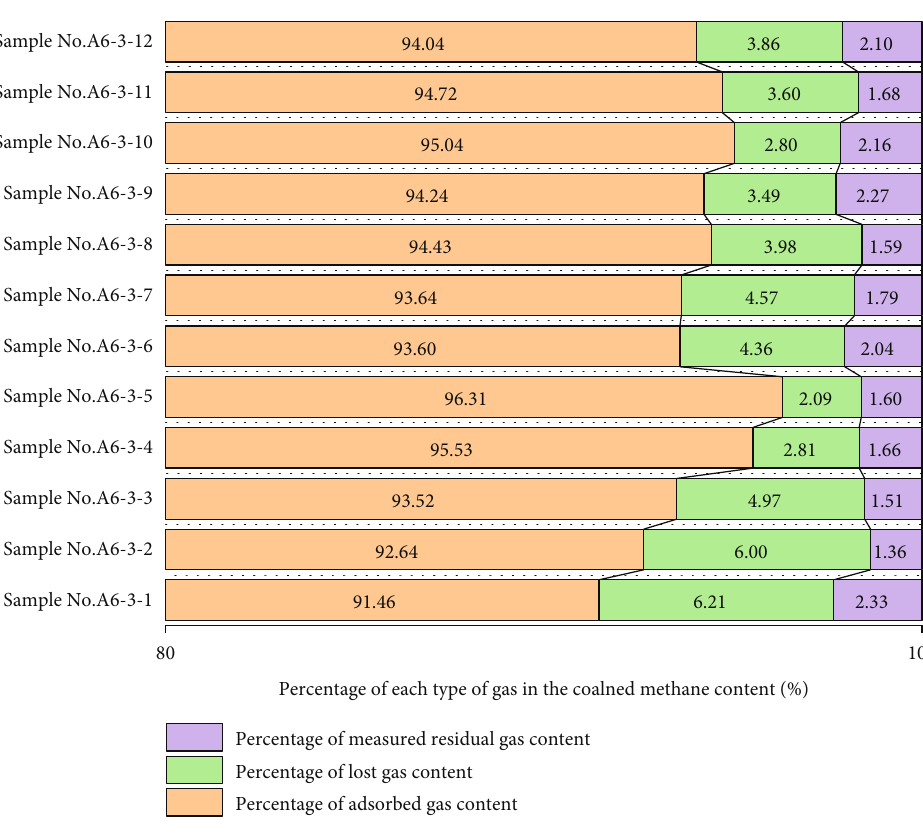
Figure 3: Proportional distribution of each type of gas content in each sample of well A6. Table 1: CBM content results of 12 sets of core coal samples from the 3 # coal seam in well